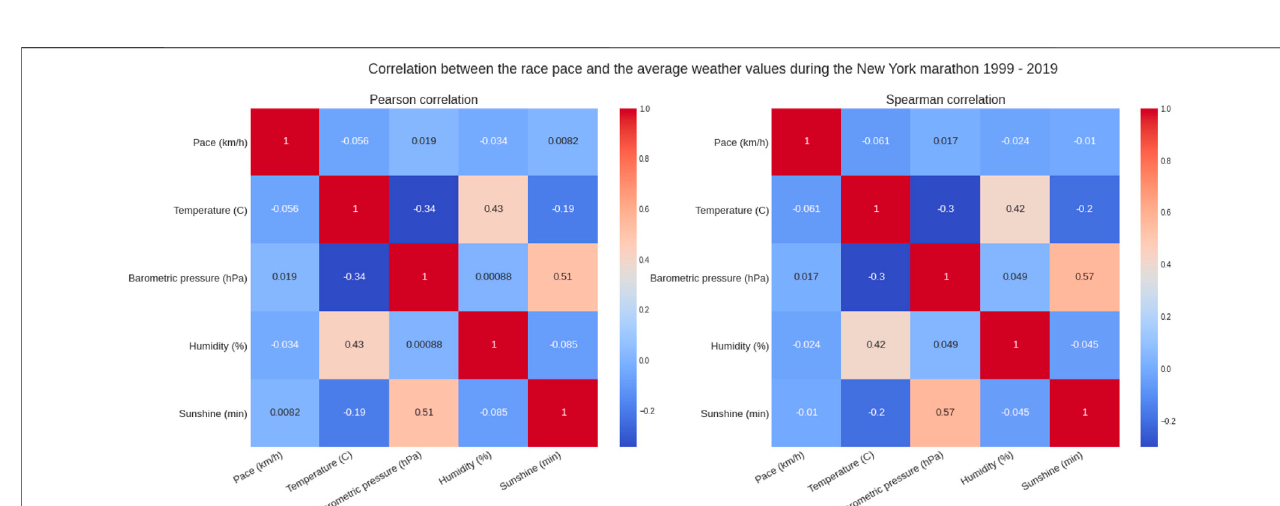
FIGURE 7 | Correlation between running speed and average weather